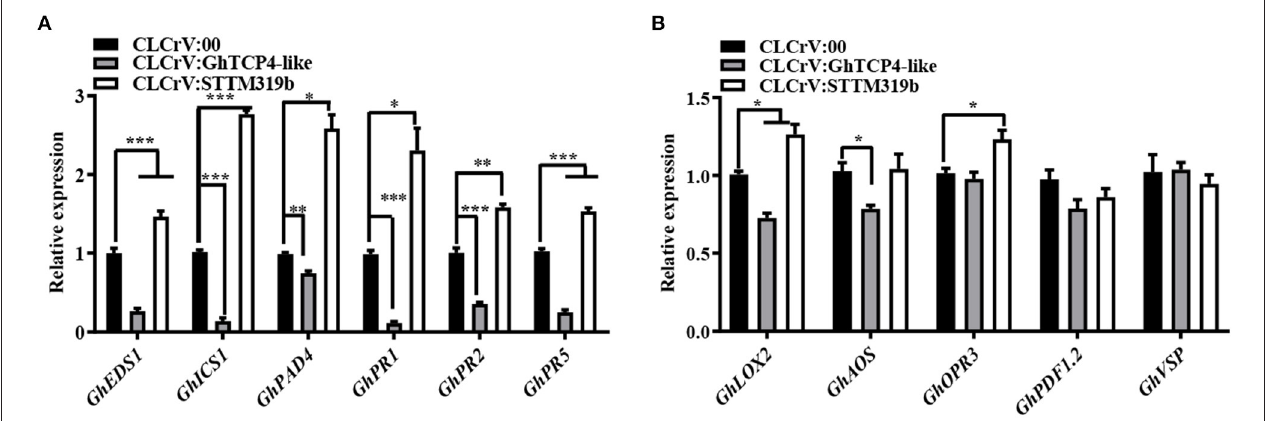
FIGURE 4 | Expression levels of SA- and JA-related genes in CLCrV:00, CLCrV:GhTCP4-like and CLCrV:STTM319b plants under V. dahliae infection. (A,B) The expression analysis of SA biosynthesis-related genes ( GhEDS1 , GhICS1 and GhPAD4 ) and SA responsive genes ( GhPR1 , GhPR2 , and GhPR5 ) in various plants 1-day post-inoculation (dpi). (B) The expression analysis of JA biosynthesis-related genes ( GhLOX2 , GhAOS , and GhOPR3 ) and JA responsive genes ( GhPDF1.2 and GhVSP ) in various plants 1 dpi. Root samples were collected from various treatments. Error bar means SD of three independent biological replications. Student’s t -test was performed, * p < 0.05, ** p < 0.01, *** p <